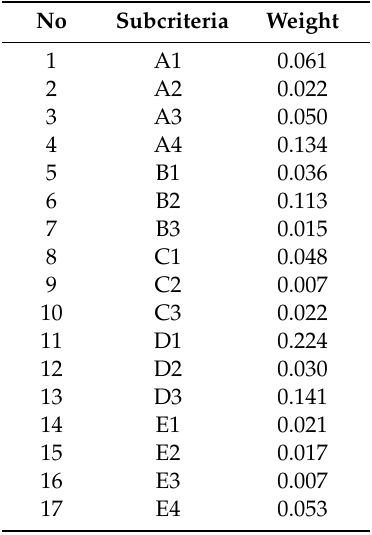
Table 10. Result of ranking the priority of the secondary criteria.